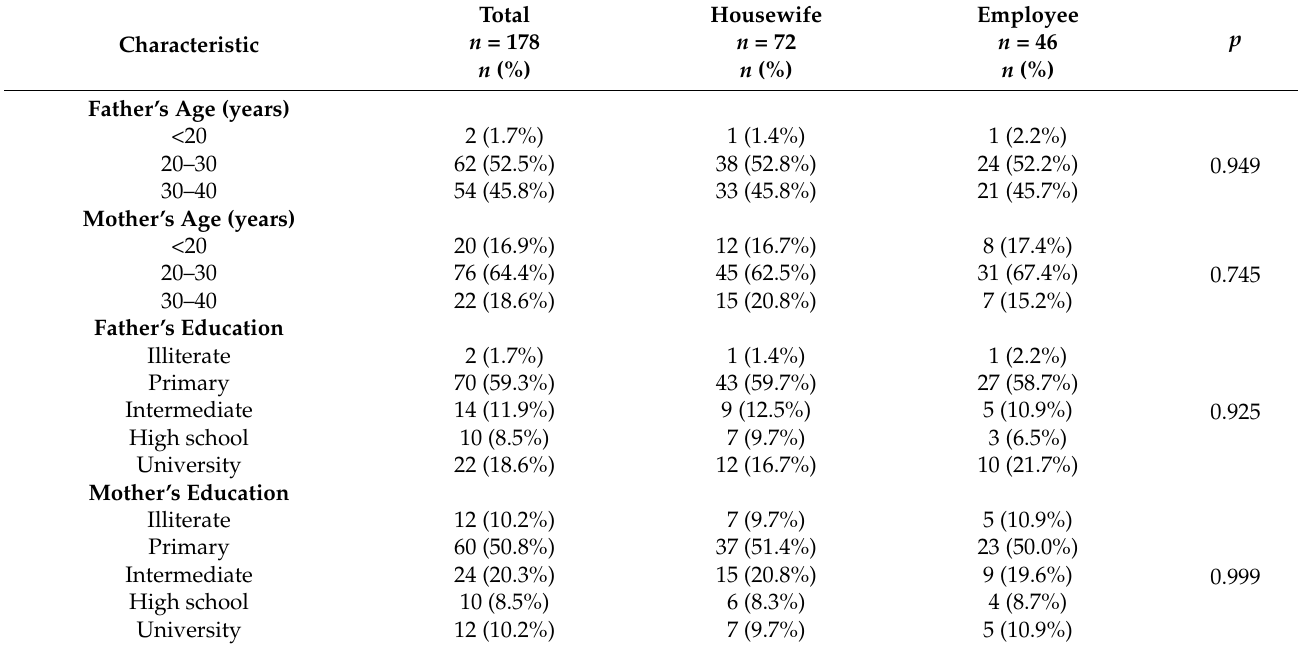
Table 2. The characteristics of care givers of CLP